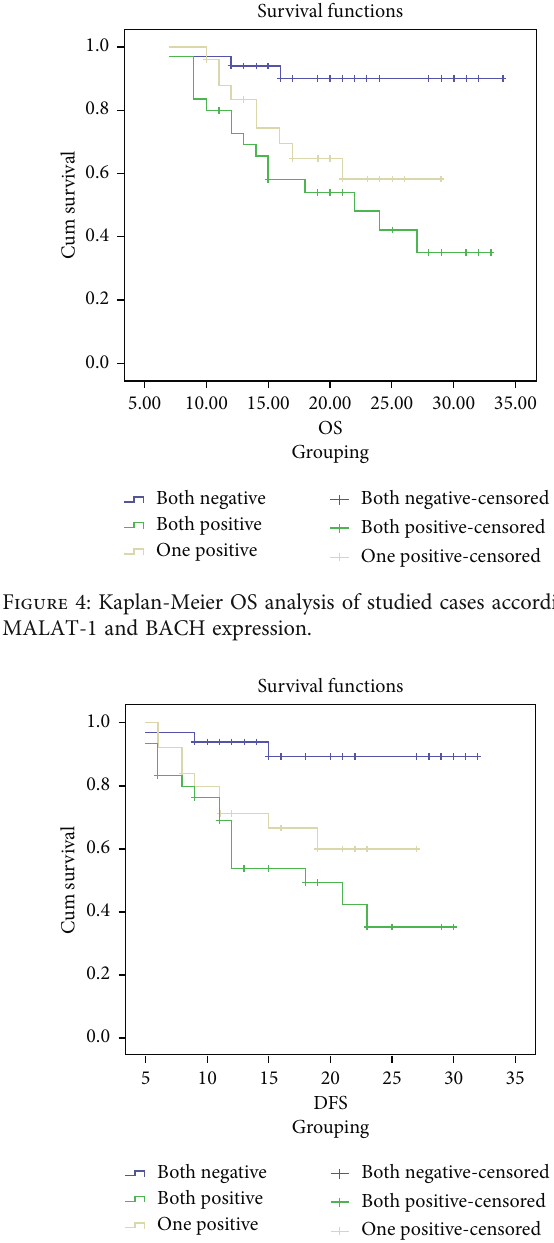
Figure 5: Kaplan-Meier DFS analysis of studied cases according to MALAT-1 and BACH